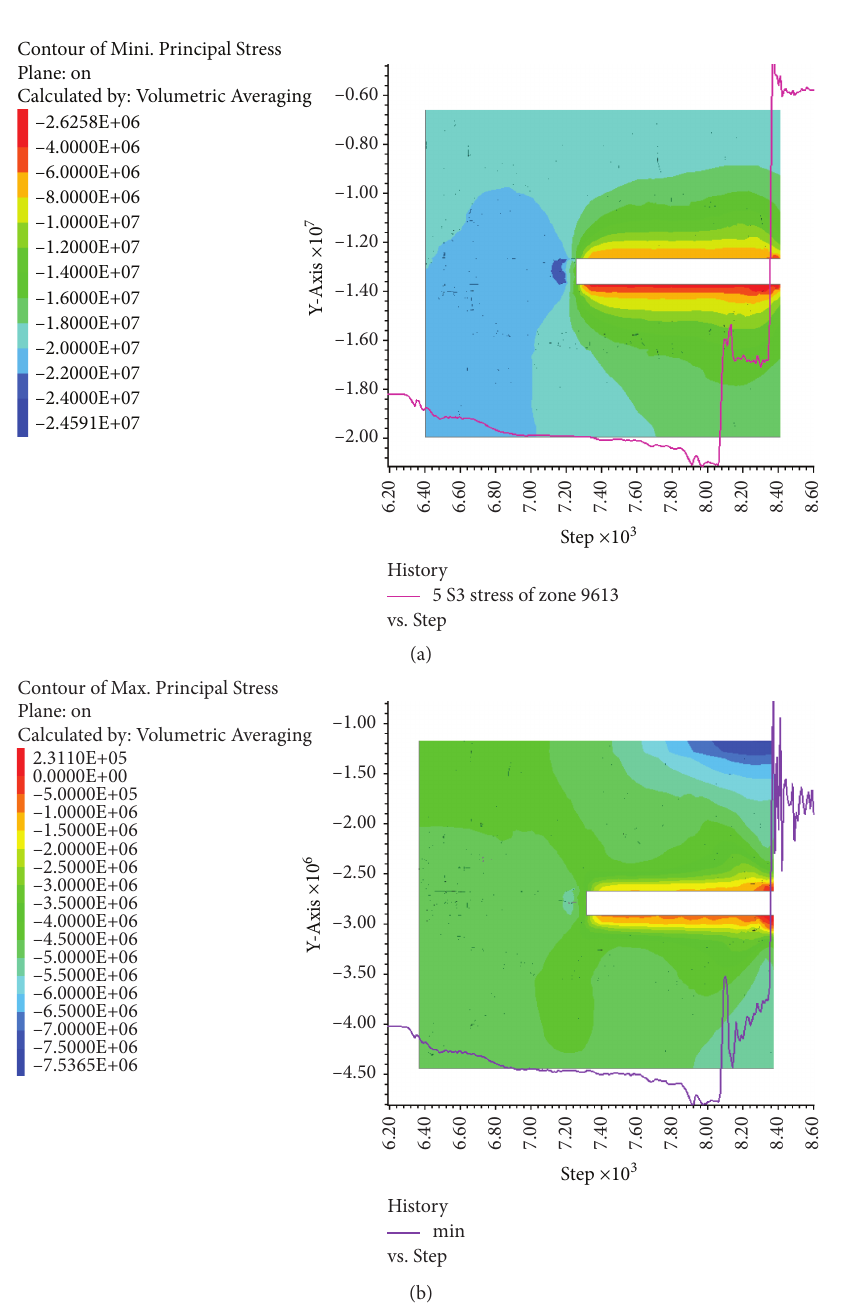
Figure 18: Variation of tunnel roof stress: (a) maximum principal stress and (b) minimum principal